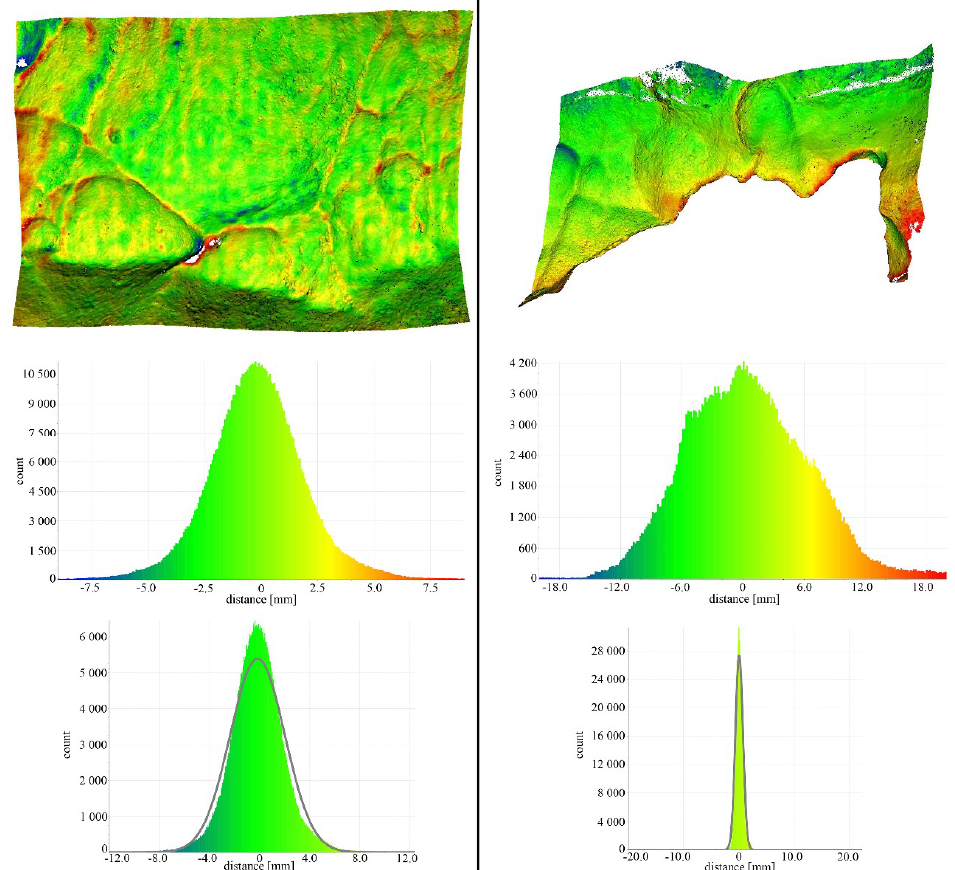
Figure 13. Difference models between two selected parts of the cave wall surface with graphical analysis of their frequency distribution, and their deviations from the normal distribution.